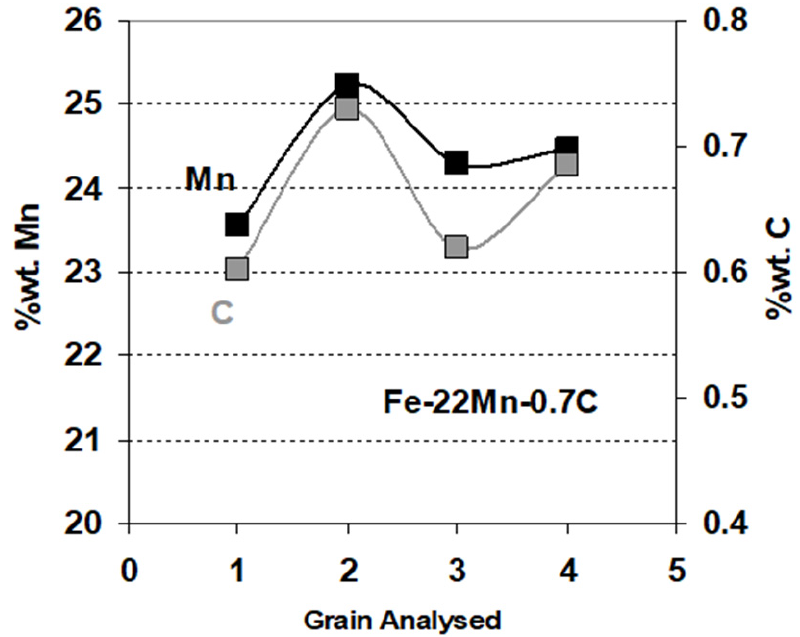
Figure 5. TEM EELS data illustrating the co ‐ segregation of carbon with manganese in cold ‐ rolled and annealed Fe ‐ 23Mn ‐ 0.7C [28].